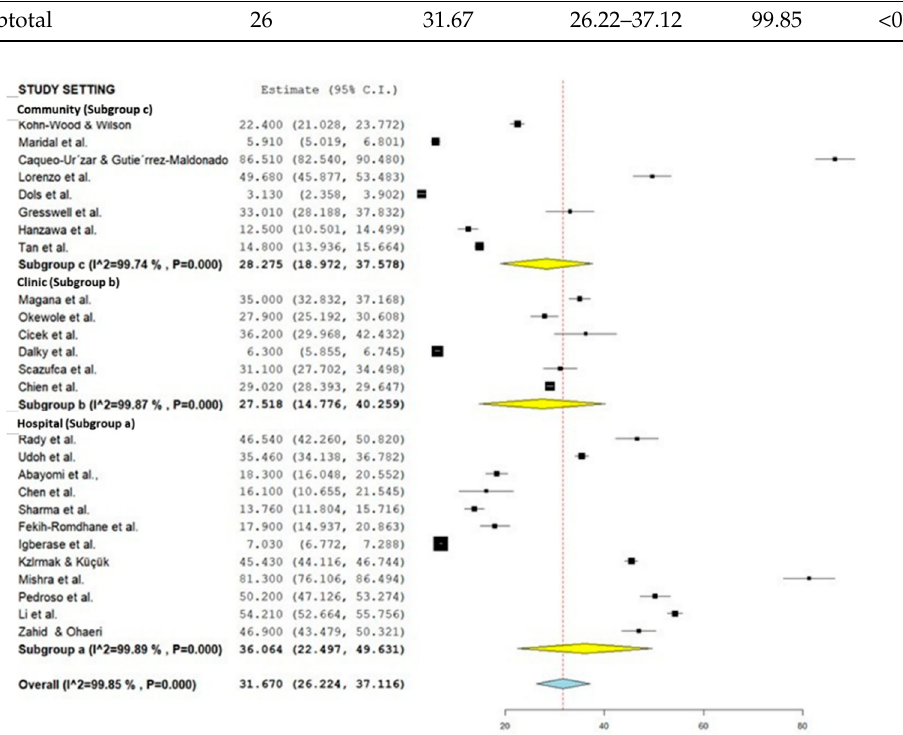
Figure 3. Subgroup forest plot on the study setting (Community: [50,58,64,68–70,75,77]; Clinic: